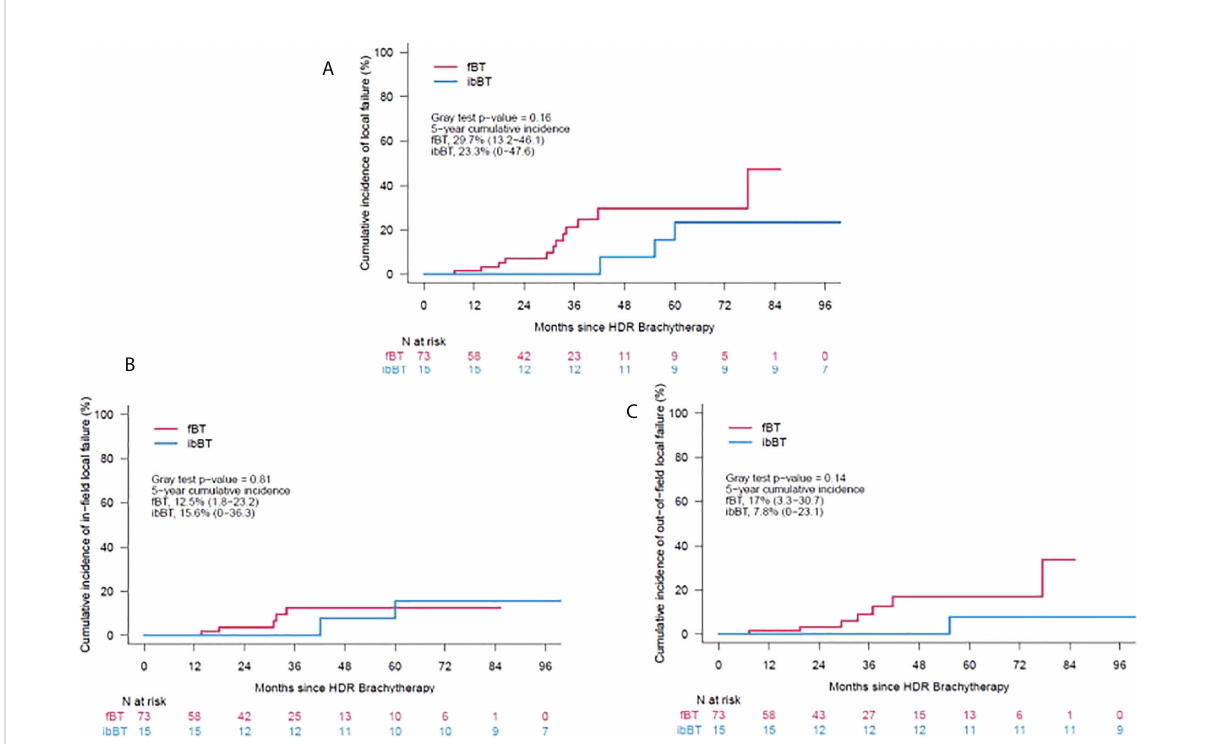
FIGURE 3 (A) – Cumulative incidence of local failure, (B) – Cumulative incidence of in- fi eld failure, (C) – Cumulative incidence of out-of- fi eld